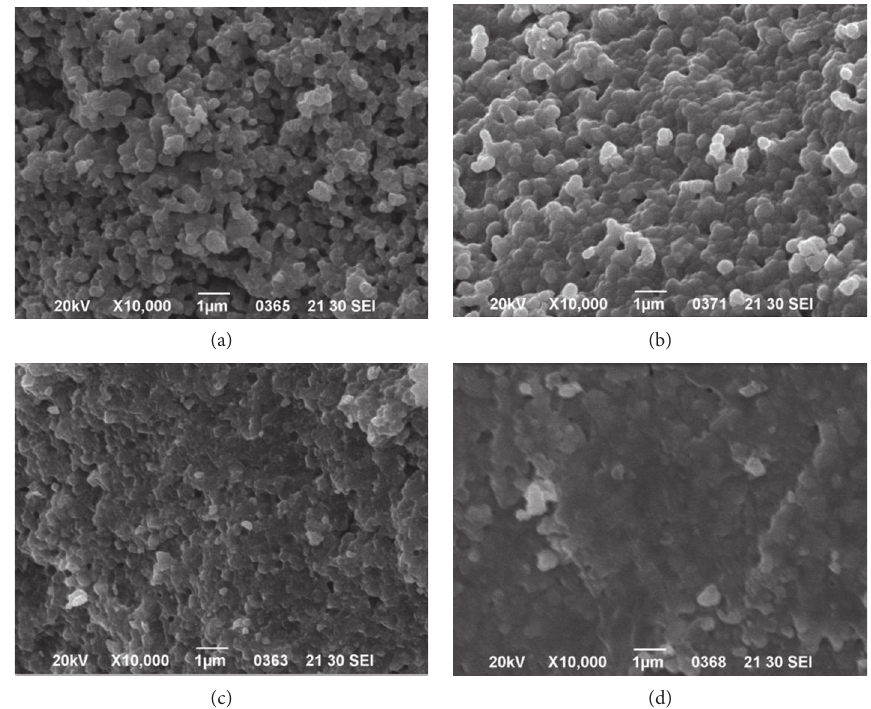
Figure 9: SEM images of four ceramic rings of group B obtained at different microwave sintering temperatures. (a) 1300 ° C, (b) 1350 ° C, (c) 1400 ° C, and (d) 1450 °